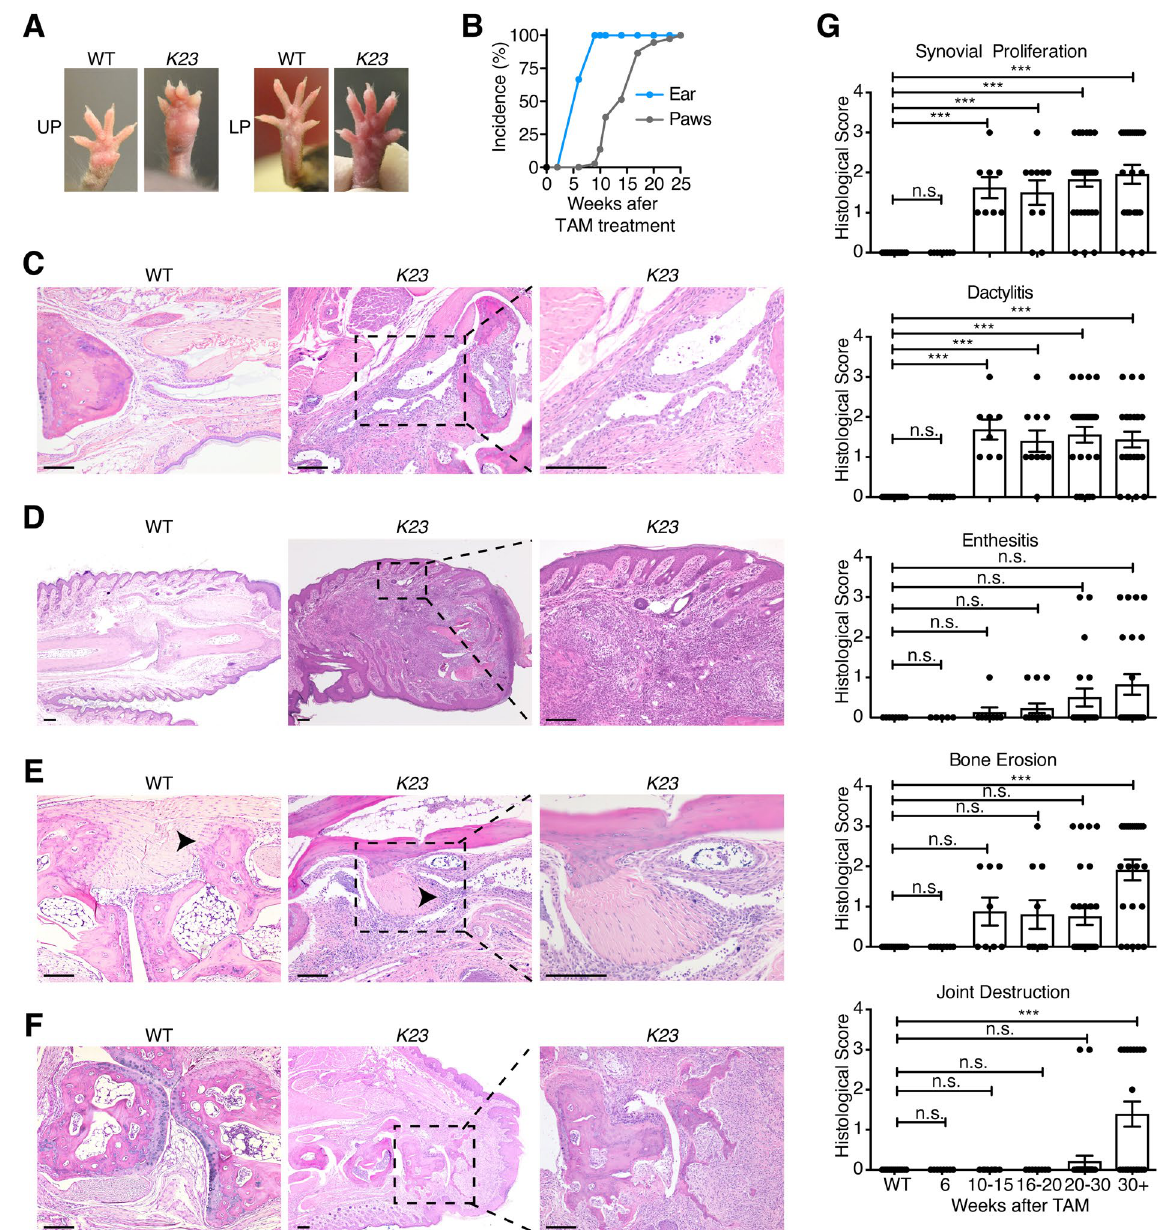
Figure 4. K23 mice develop psoriatic-arthritis-like disease after TAM treatment. ( A ) Representative macroscopic view of paws of K23 mice. K23 mice treated with TAM develop inflammation in the upper (UP) and lower (LP) paws (n = 37 mice). ( B ) Incidence of disease in ears and paws of K23 mice after TAM administration (n = 11–15 mice/group). ( C – F ) Representative H&E staining of paws and joints of WT and K23 mice after TAM treatment. Arthritis in K23 mice joints showed synovial proliferation ( C ), dactylitis ( D ), enthesitis ( E ), and joint destruction with acriisteiktsus ( F ). Scale bars, 100 μ m. ( G ) Histopathological scores of WT and K23 mice after TAM treatment at different time points. n = 4–16 mice/group. Data are shown as mean ± SEM, ns, p > 0.05, *** p < 0.001 by one-way ANOVA followed by Dunnett’s multiple comparison